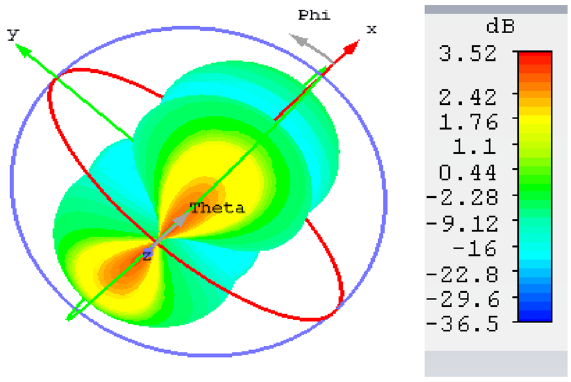
Fig. 8 Radiation pattern of the graphene nano